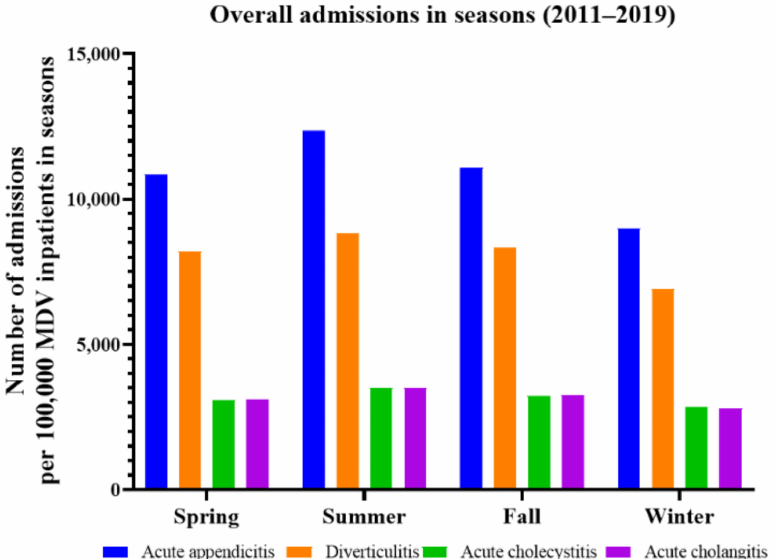
Figure 3. The seasonal admissions for acute appendicitis, diverticulitis, acute cholecystitis, and acute cholangitis were clearly higher in summer than winter, with meaningful differences. MDV, medical data